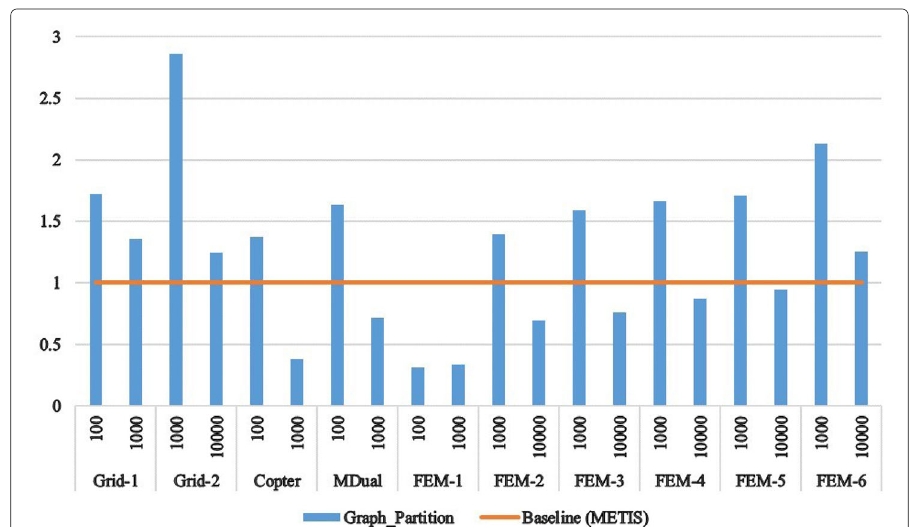
Fig. 10 The ratios of running time of our algorithm to that of